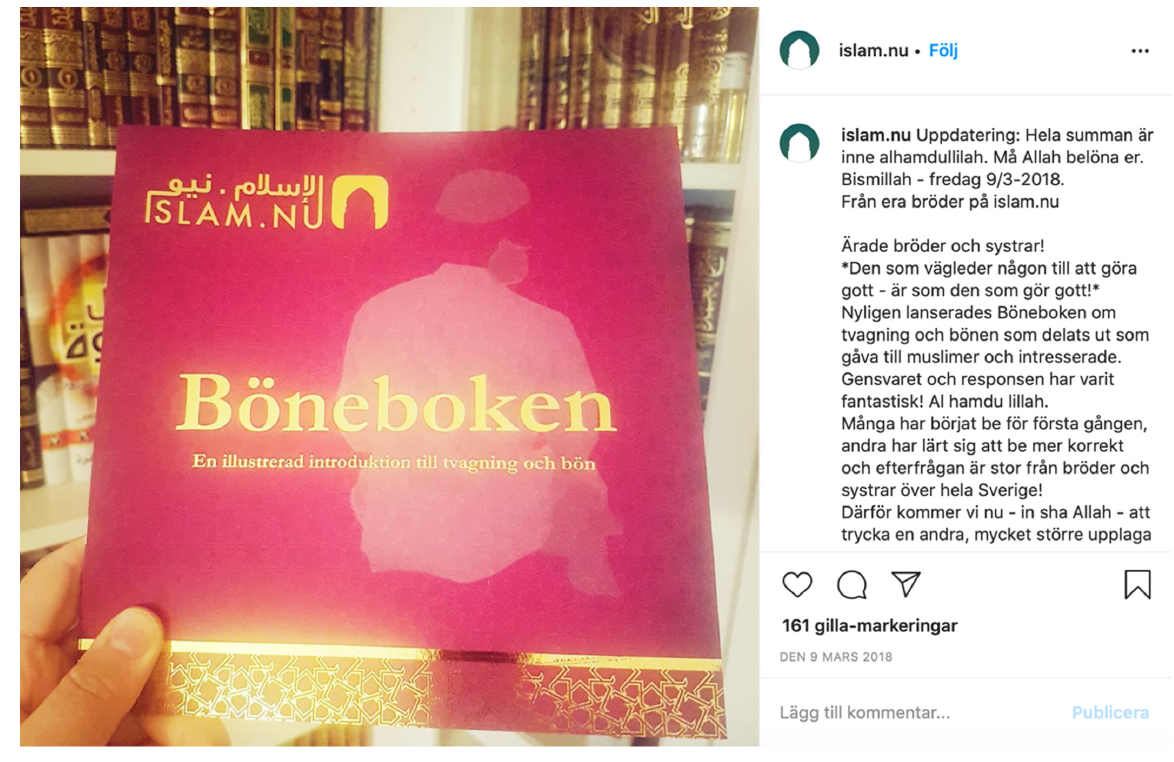
Figure 2. The Prayer Book.